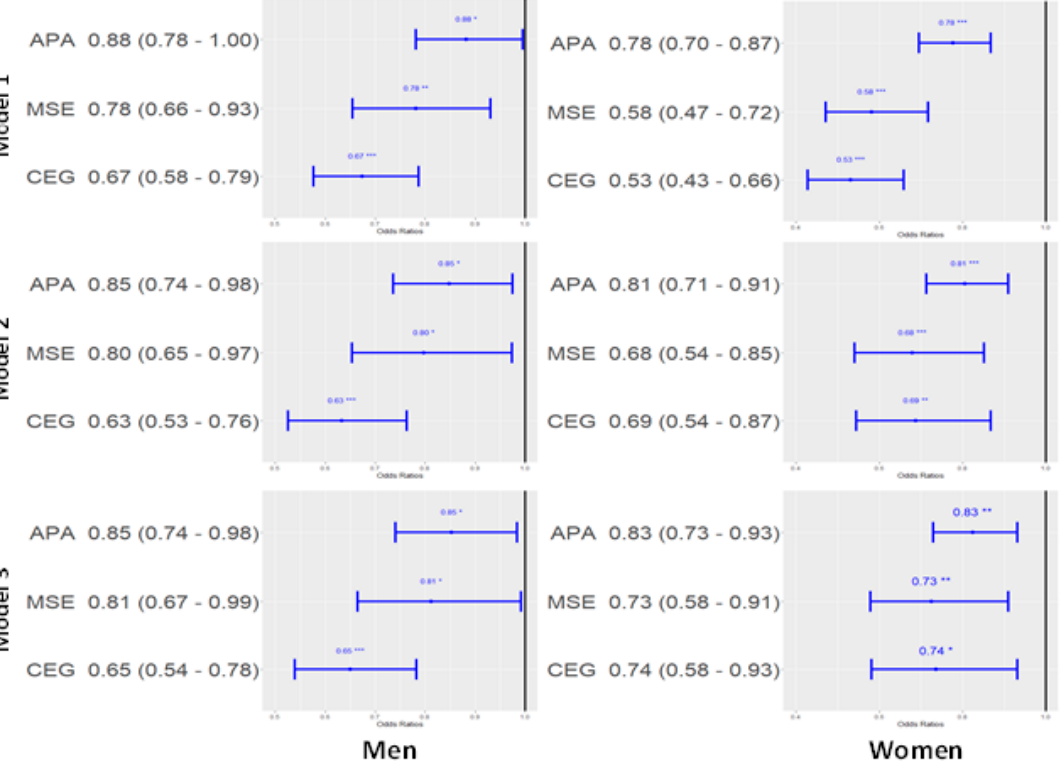
Figure 1. Odds ratio and 95% confidence interval of each exercise group on the prevalence of meta-